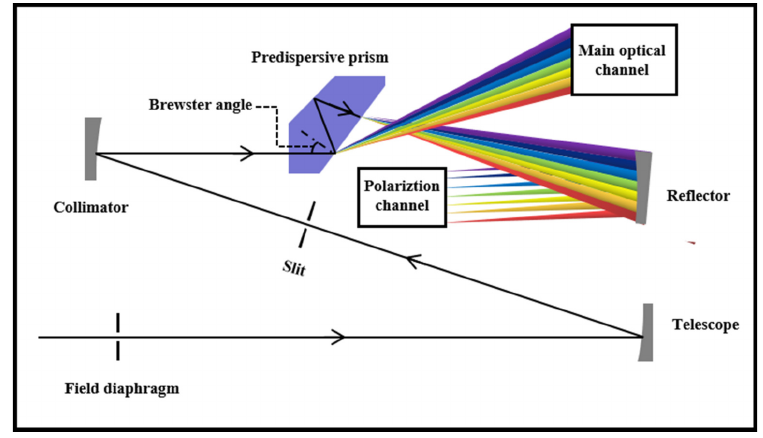
Figure 4. Optical structure diagram of polarization